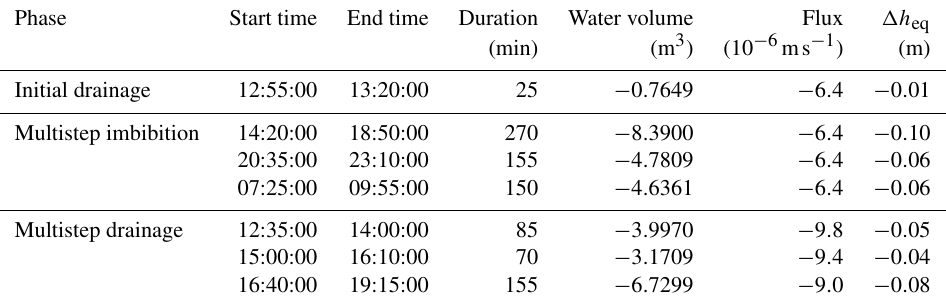
Table 2. During the experiment, ASSESS was forced with a fluctuating groundwater table. Therefore, 17 . 8m 3 of water were pumped in and 14 . 7m 3 were pumped out of the groundwater well. For the calculation of the according flux and equivalent height of the water column (cid:49)h eq , the surface area of ASSESS was approximated with 80m 2 . All times are given in